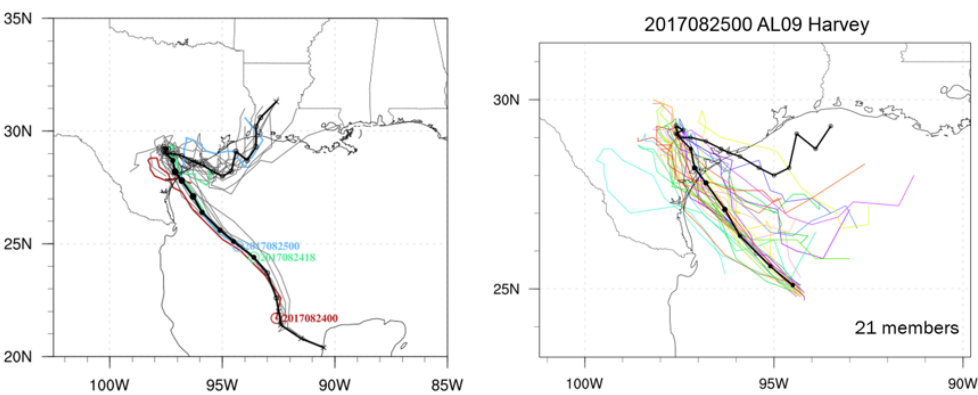
Figure 2. Left panel: HB17 deterministic track forecasts for Hurricane Harvey in the Gulf of Mexico: 0000 UTC 24 August 2017 (red line), 1800 UTC 24 August 2017 (green), and 0000 UTC 25 August 2017 (blue). Gray lines represent the track forecasts from unselected cycles. Right panel: H17E ensemble track forecasts for Hurricane Harvey on 0000 UTC 25 August 2017 are shown in colored lines. The black line is the Best